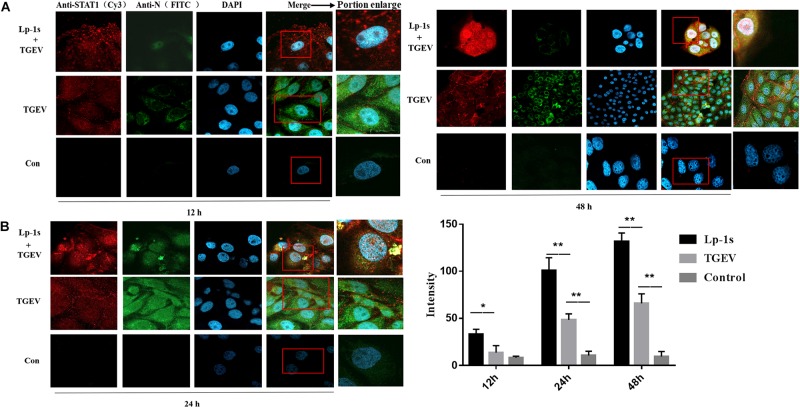
Identification of nuclear translocation in porcine p-STAT by IFA (magnification: 63×). Lp-1s, Lp-1s pretreatment of IPEC-J2 cells infected with TGEV; TGEV, cells directly infected with TGEV; Con, uninfected cells (normal group). (A) Anti-pSTAT1 (Cy3), goat anti-rabbit IgG Cy3 labeled p-STAT1 protein; Anti-TGEV N (FITC), goat anti-mouse IgG FITC labeled TGEV N protein; DAPI, DAPI nuclear staining; Merge, fused image of the three fluorescent images. (B) The nucleus was identified using Zen blue software and the intensity of red fluorescence emitted by Cy3-labeled p-STAT1 was analyzed. The statistical results showed that the fluorescence intensity of Cy3 in IPEC-J2 cells treated with Lp-1s was significantly higher than that in the TGEV group after 12 h (∗P < 0.05). In the late stage of TGEV infection (24–48 h), the fluorescence signal intensity of p-STAT1 in the nucleus of this group was significantly higher than that in TGEV group (∗∗P < 0.01).